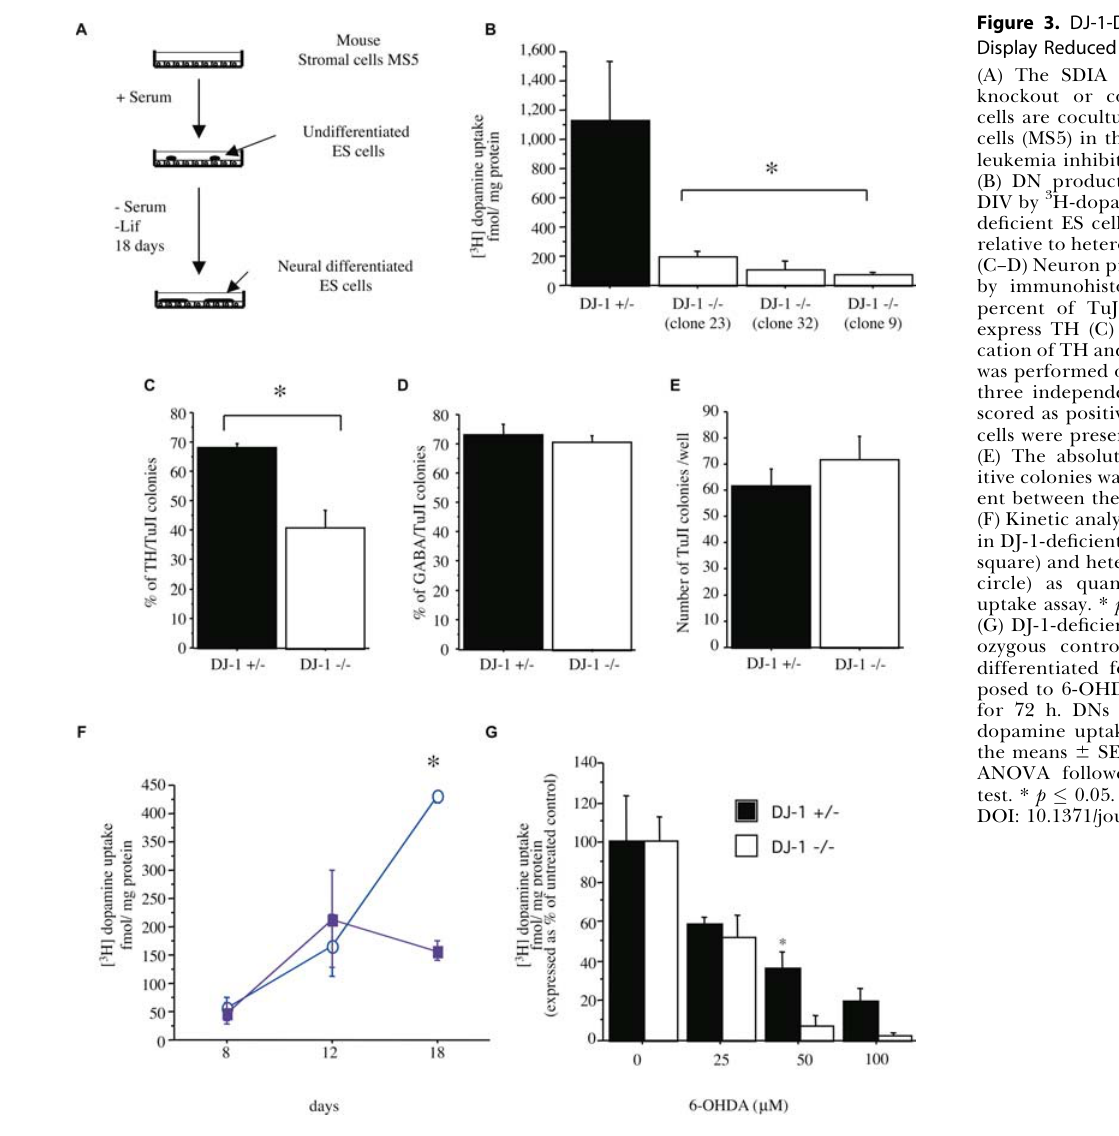
Figure 4. Neuronal Differentiation of DJ-1-Deficient and Control Heterozygous ES Cell Cultures (A–L) DJ-1 heterozygous ( þ /–; A–F) and knockout (–/– [clone 32]; G–L) cultures were differentiated by SDIA for 18 DIV and immunostained with antibodies to TH (green) and TuJ1 (red). Images of both (Merge) are also shown. (A 9 –L 9 ) Immunostaining of DJ-1 heterozygous ( þ /–, A 9 –F 9 ) and deficient (–/–, G 9 –L 9 ) cultures with antibodies for GABA (green) and TuJ1 (red). Scale bar, 50 l m. Images of both (Merge) are also